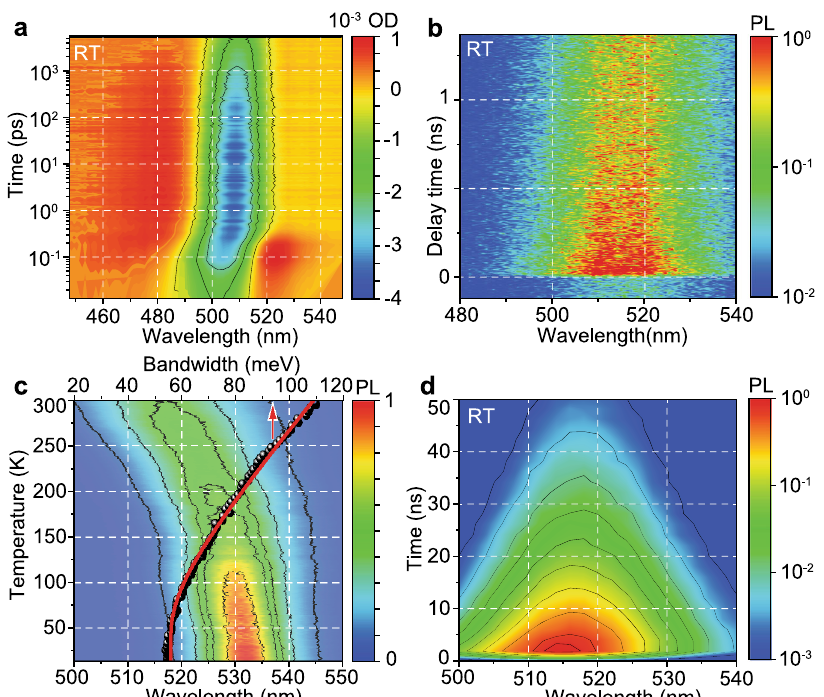
Fig. 2 Optical spectroscopy characterization of {en}FAPbBr3 NC fi lm. 2D pseudo-colour plots for fast decay range: a transient absorption, 0 – 5 ns and b transient PL, 0 – 1.5 ns of; c 2D pseudo-colour plot of temperature dependence of PL emission, data points and fi tting curve (abscise axis is on top) ̶ bandwidth parameter of Lorentzian fi t for the PL spectra at the corresponding temperature; d 2D pseudo-colour plots for time-resolved PL for long decay range, 0 – 50